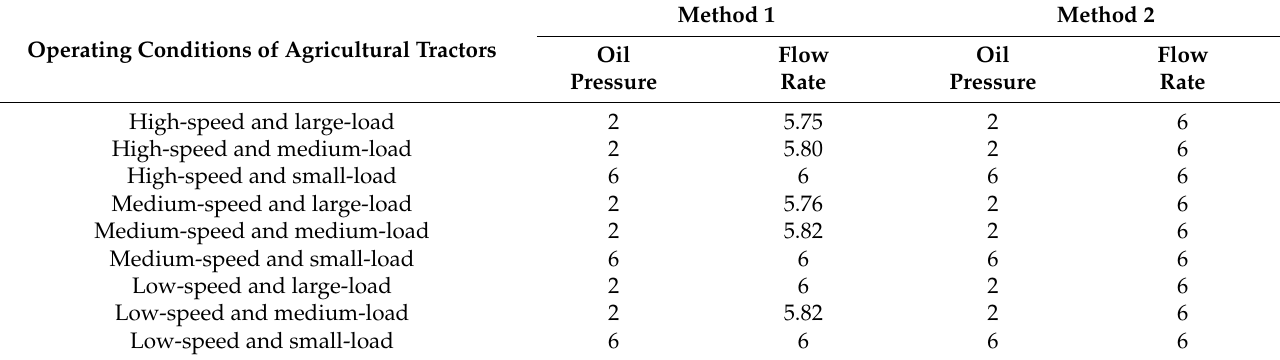
Table 6. Adjustable factor control strategy for wet clutch switching.